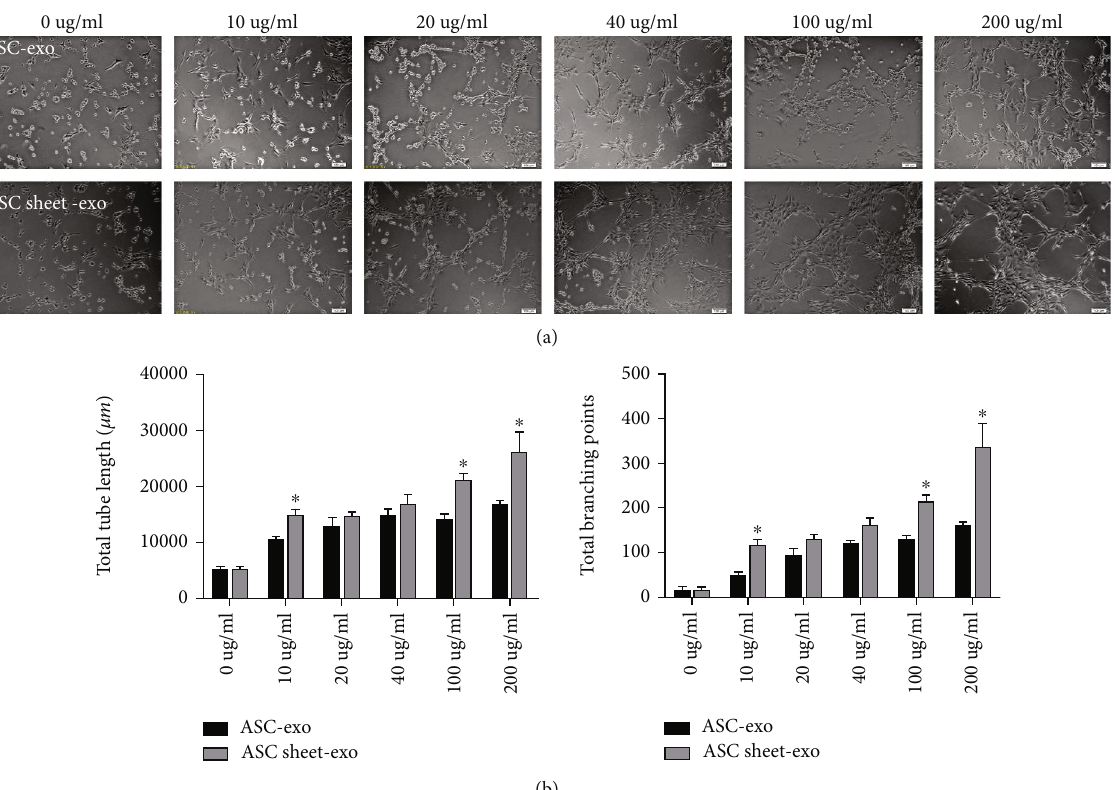
Figure 14: Angiogenic e ff ects of ASC-exo and ASC sheet-exo in tube formation assay. (a) Representative images of ECs that had newly formed tubes on Matrigel at 6h. Scale bars: 100 μ m. (b) Graph showing the number of total branching points and total tube length. ∗ p < 0 : 05 , versus the control group; # p < 0 : 05 , versus the ASC-exo